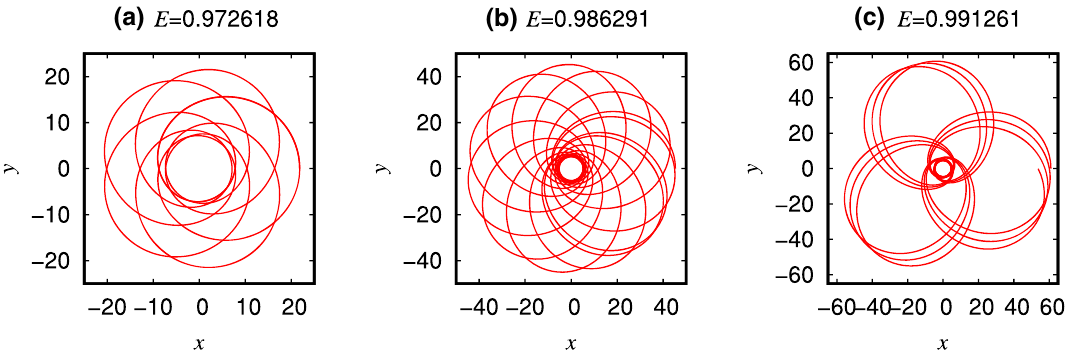
Fig. 10 Charged test particles’ bounded trajectories around quantum- corrected Schwarzschild black holes immersed in an external asymptot- icallyuniformmagneticfieldwith b = 0 . 5, ω B = 0 . 001and l = − 3 .